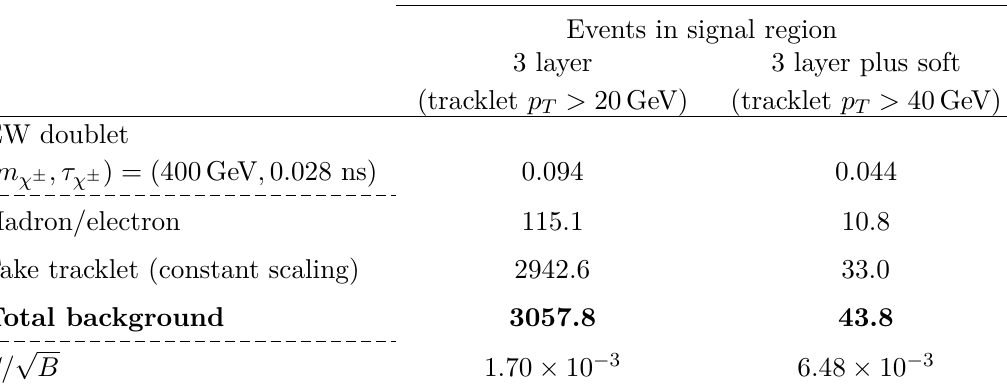
Figure 10 . The truth p T distribution of soft pions produced in the chargino decay, for two pure higgsino signal benchmarks.